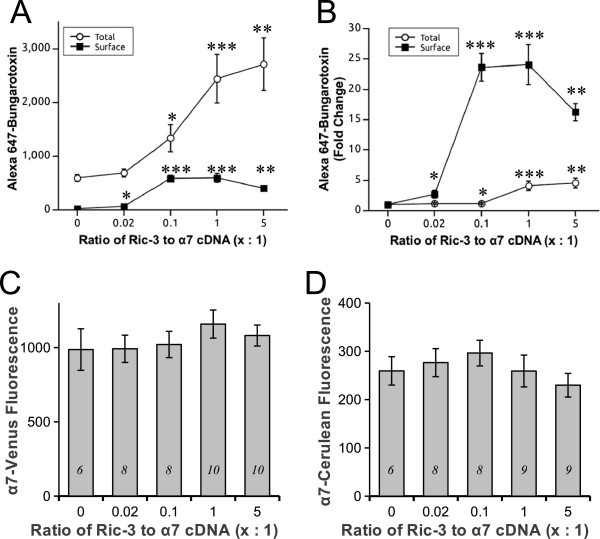
RIC-3 increases whole cell Fl-Bgt labelling and surface trafficking of α7 receptors but does not alter protein levels. Increasing concentrations of RIC-3 progressively augmented total Fl-Bgt binding under cell permeabilizing conditions (A, B). Fl-Bgt binding of surface α7 receptors also increased with RIC-3 but peaked at 1:1 RIC-3 to α7 and diminished at a 5:1 ratio (A, B). Total (A) and fold-change (B) of Fl-Bgt binding is shown. The surface and whole cell number of Fl-Bgt binding sites was quantified by measuring the integrated density of fluorescence intensities of Alexa 648-tagged α-bungarotoxin around the outer surface of each cell or within the cell, for non-permeabilizing and permeabilizing conditions, respectively. Significant difference levels comparing groups of RIC-3 coexpressing cells relative to no RIC-3 controls: * p < 0.05, ** p < 0.01, *** p < 0.001 Wilcoxon rank sum test post-hoc pair wise analysis. The number of cells analyzed for total receptor labelling in (A, B) are 0:1 (negative control, n = 14), 0.02:1 (n = 13), 0.1:1 (n = 14), 1:1 (n = 18), and 5:1 (n = 15). The number of cells analyzed for surface receptor labelling in (A, B) are 0:1 (n = 6), 0.02:1 (n = 8), 0.1:1 (n = 8), 1:1 (n = 11), and 5:1 (n = 11). (C, D) Mean emission intensity of the α7-Venus and α7-Cerulean fluorophores per HEK293T cell were determined at various concentrations of RIC-3. There was no significant change in either α7-Venus or α7-Cerulean fluorescent protein levels with various amounts of RIC-3 co-expressed inside the cells (p = 0.6, one-way ANOVAs; and p = 0.2, Kruskal-Wallis rank sum test, respectively).